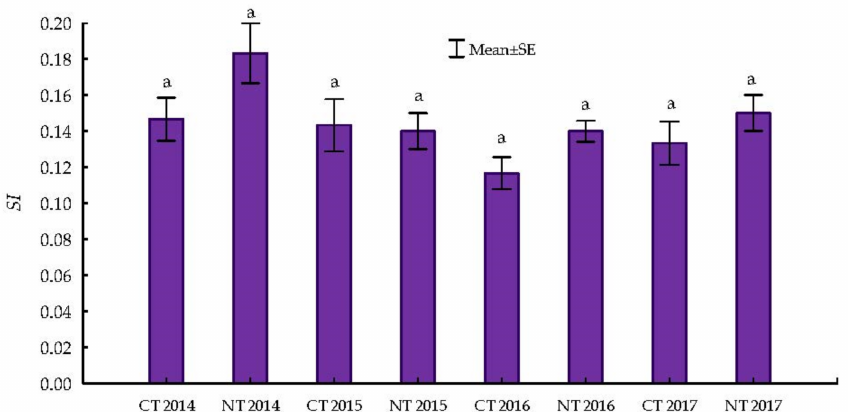
Figure 9. Interactive dependencies of tillage systems and years of research in shaping of Simpson’s dominance index (SI) of weed community in winter oilseed rape crop. CT—Conventional tillage; NT—No-tillage. The same letter means not significantly different values ( p ≤